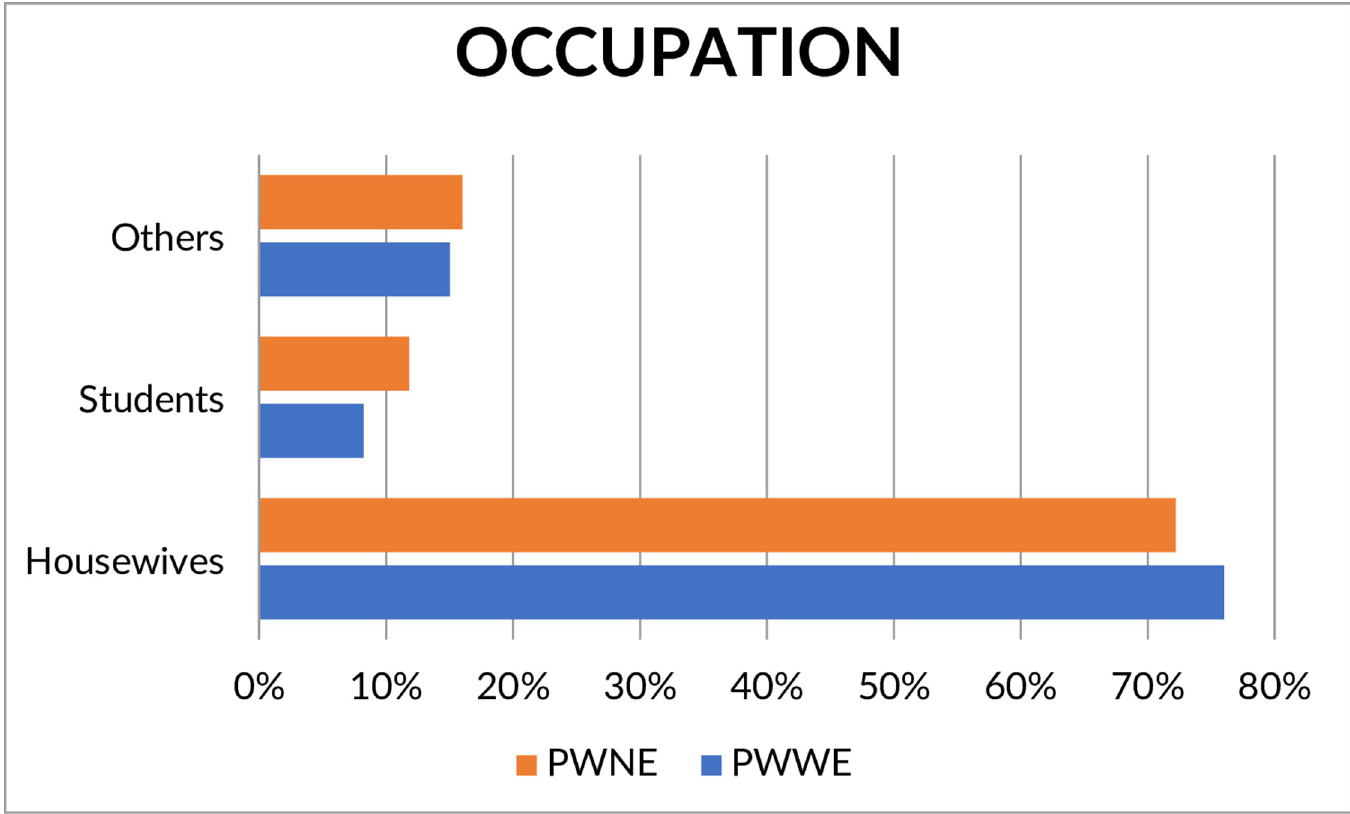
Fig 2. Comparison of professional occupations between pregnant women with (PWWE) and without epilepsy (PWNE). The figure shows that pregnant women without epilepsy are students and have professional occupations while most pregnant women with epilepsy are housewives.